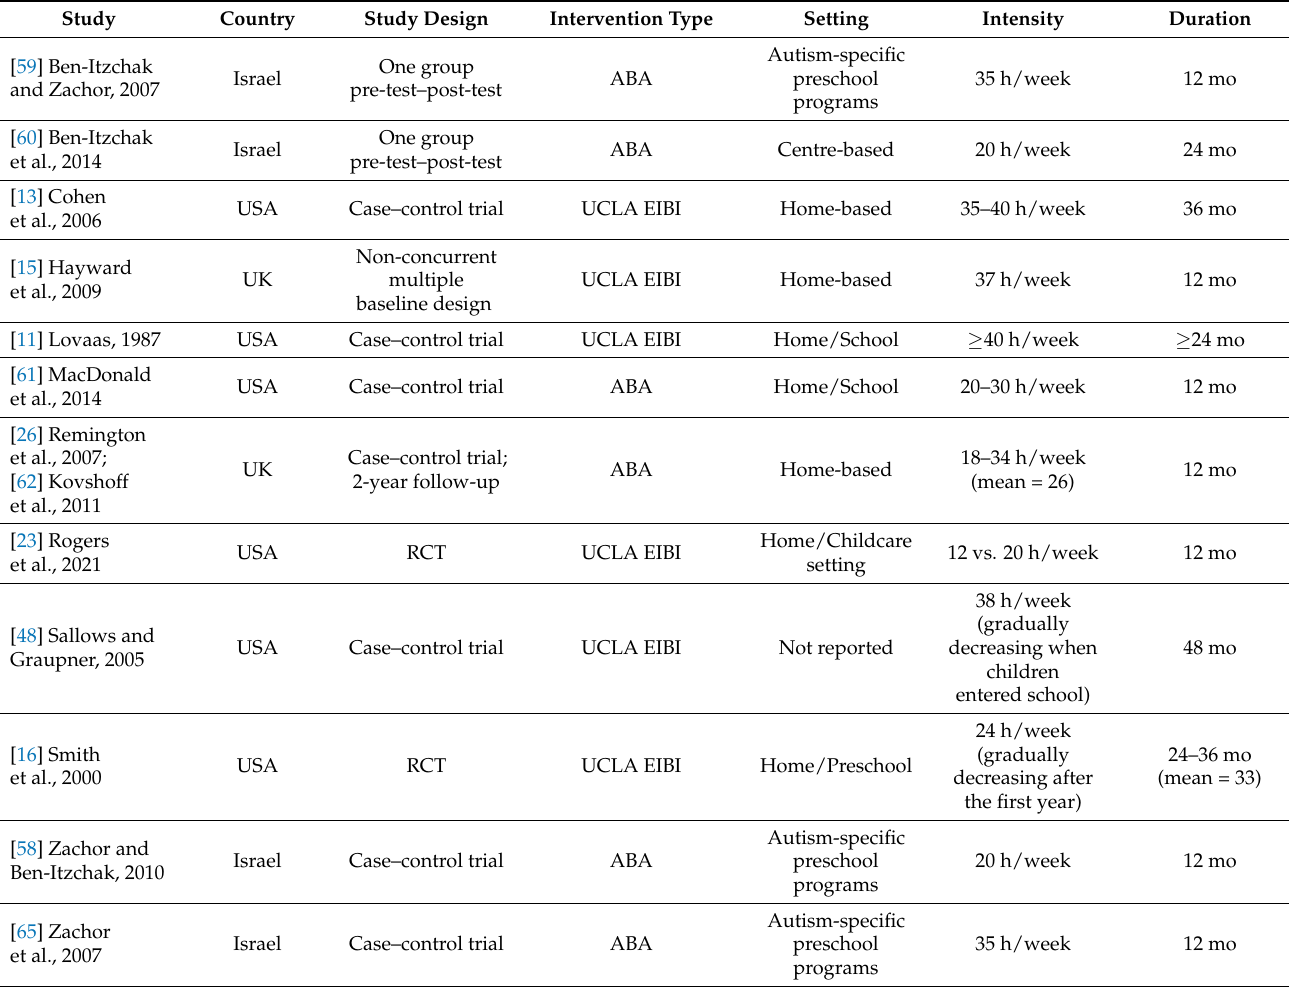
Table 2. Summary of EIBI studies: intervention